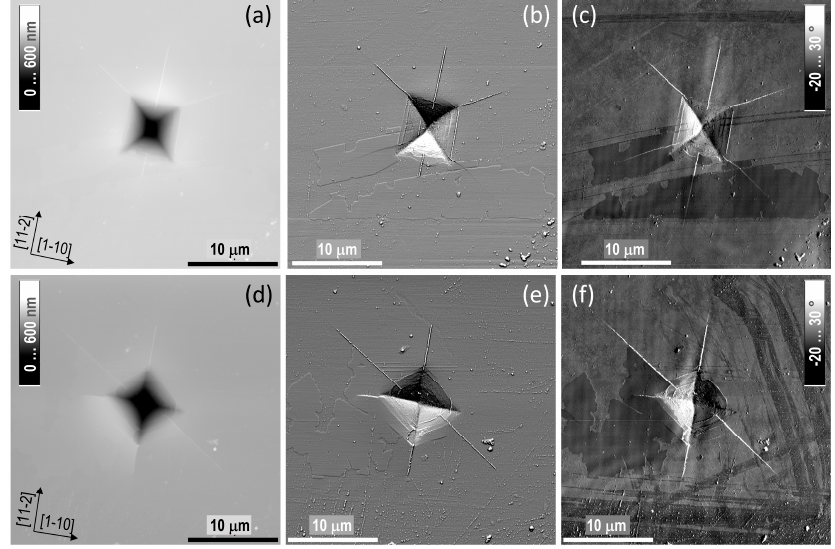
Figure 7. ( a – c ) AFM images of orientations B and ( d – f ) orientation A of Vickers indents on the (111) cBN (1.96-N load): ( a , d ) topography, ( b , e ) derivative topography, and ( c , f ) phase contrast.